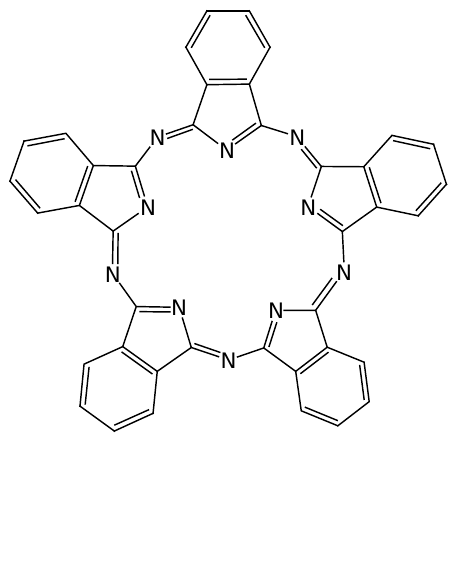
Figure 5. Phthalocyanine.